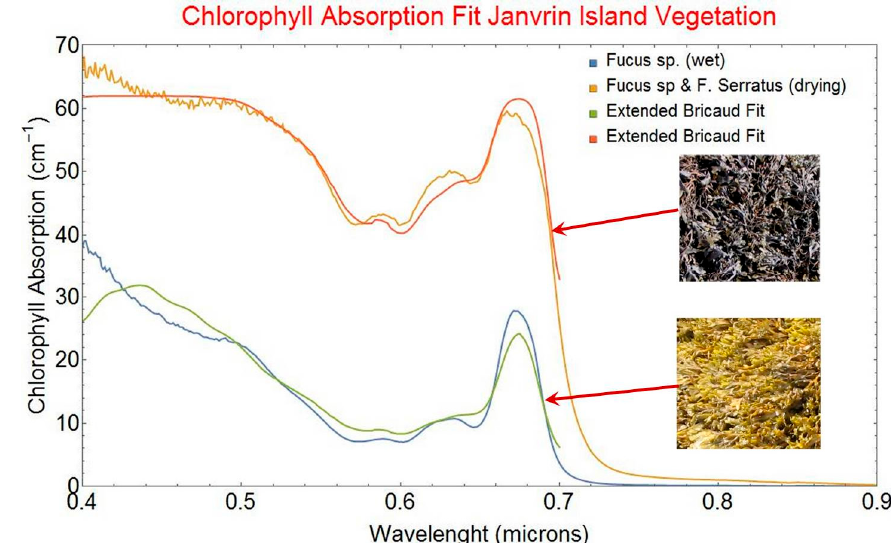
Figure 6. Fit of the absorption spectrum of wet Fucus sp. and a drying mixture of Fucus sp. and F. serratus with the extended Bricaud model. Note the noise due to the instrumental signal to noise degradation in the blue wavelength range. This effect was compensated by weighing the fit function inversely proportional to the S/N. The blue and yellow curves are the derived spectrum from the reflectance measurements and Equation (29). The green and red curves are the fit using Equation (37).